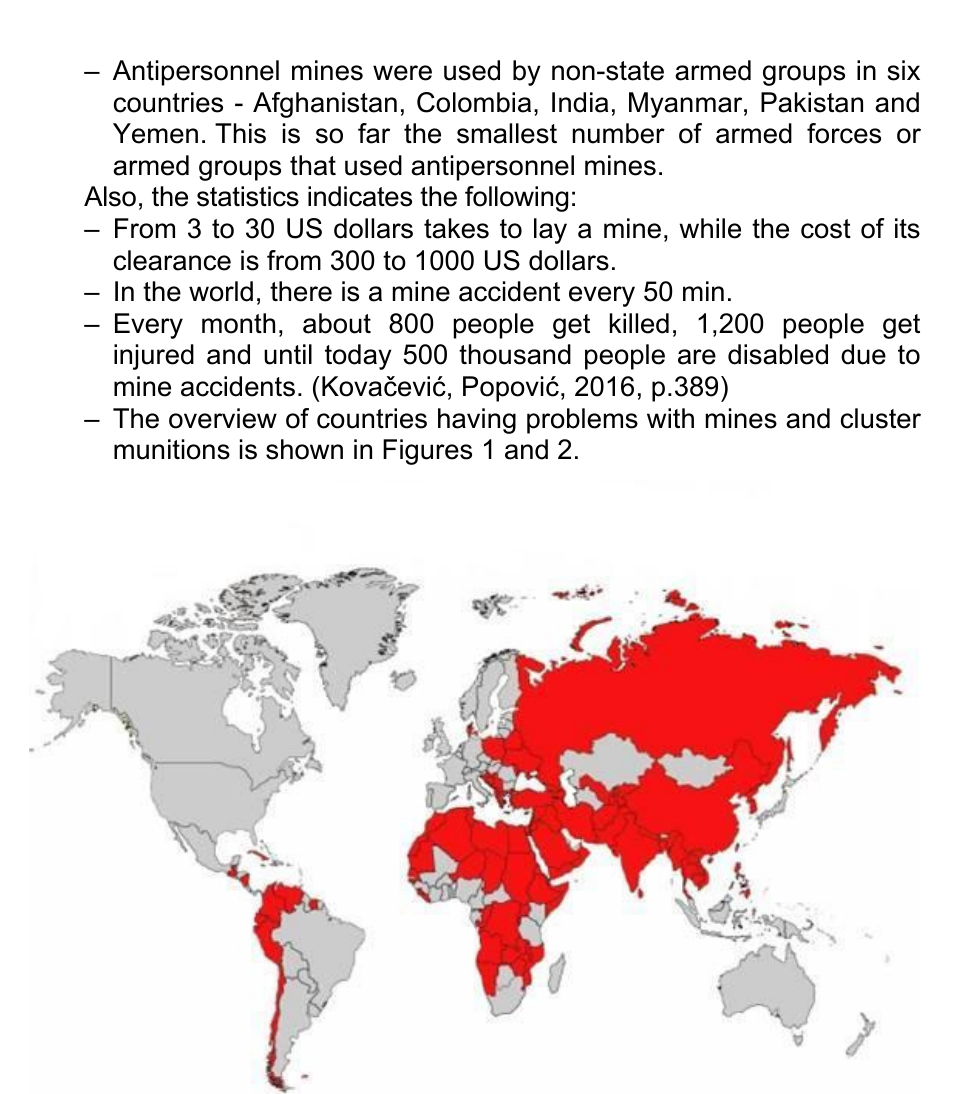
Figure 1 – World countries with mine risks (marked in red) Рис . 1 – Страны , в которых существует минная